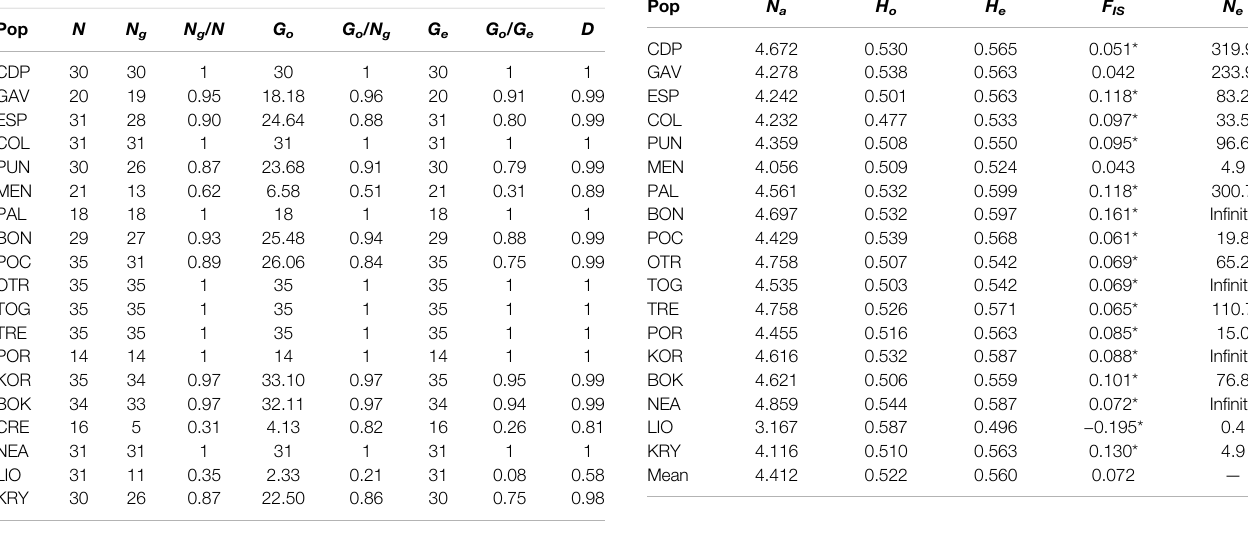
TABLE2| Genotypicdiversityoftheanalysedpopulationsof C.caespitosa based on 19 microsatellites. N , number of polyps (colonies) sampled; N g , number of unique multilocus genotypes per site; N g /N , genotypic richness; G o , observed genotypic diversity; G o /N g , genotypic evenness; G e , expected genotypic diversity( N ); G o /G e , genotypic diversity and the D index.